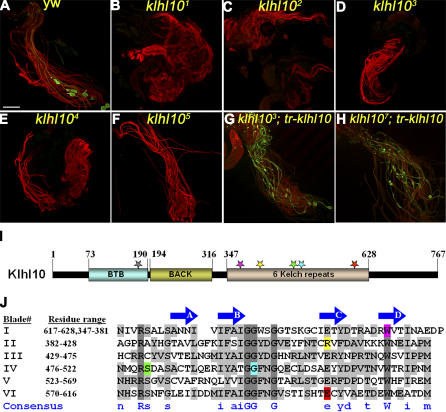
Mutations in klhl10 Block Caspase Activation and Spermatid Individualization, but Not Axonemal Tubulin Polyglycylation(A–H) Visualization of active effector caspase with anti-cleaved caspase-3 antibody (CM1; green) and (A–F) axonemal tubulin polyglycylation with anti-glycylated tubulin monoclonal antibody (AXO 49; red) or (G–H) F-actin, which stains the ICs and the spermatids' tails (phalloidin; red). These figures are composed of combined green and red layers.(A) Wild-type individualizing spermatids positively stain for cleaved caspase-3 and polyglycylated axonemal tubulin.(B–F) In a variety of klhl10
−/− alleles, elongated spermatids stain for polyglycylation but not for cleaved caspase-3.(G and H) Transgenic klhl10 construct (tr-klhl10, composed of cul3Testis promoter and 5′ UTR, klhl10 coding region, and cul3Testis 3′ UTR) restores caspase activation, spermatid individualization, and fertility to klhl10
−/− male flies.(I) Schematic representation of the Klhl10 protein. The relative locations of the BTB, BACK, and Kelch domains are depicted by thick bars. Different colored stars depict the locations of the different mutations, and the colors correspond to the colored amino-acids in (J). The molecular nature of the mutations and their color code are as follows: klhl102 (Z2–1331) carries a G1801-to-A transversion that converts glutamic acid (E601, red) to lysine at repeat VI. klhl103 (Z2–0960) carries a G1119-to-A transversion that converts tryptophan (W373, purple) to stop codon, resulting in a deletion of most of the Kelch domain. klhl104 (Z2–2739) carries a C1237-to-T transversion that converts arginine (R413, yellow) to stop codon, which also deletes most of the Kelch repeats. klhl105 (Z2–3284) carries a G1486-to-A transversion that converts glycine (G496, blue) to arginine at repeat IV. klhl106 (Z2–4385) carries a C1439-to-T transversion that converts serine (S480, green) to phenylalanine at repeat IV. On the other hand, klhl107 (Z2–3353) carries a G508-to-A transversion that converts a highly conserved alanine (A170) to threonine in the BTB domain (gray star).(J) Alignment of the six Kelch repeats of Klhl10. The alignment is based on the crystal structure of the Keap1 Kelch domain which folds into a β-propeller structure with 6 blades. The residue range for each blade is indicated at the left. The four conserved β-strands in each blade are indicated above the sequences by arrows. Residues conserved in all six blades are highlighted with dark gray and appear in upper case in the consensus line, whereas residues that are conserved in at least three blades appear in lower case. Any two and above conserved residues are highlighted with light gray. Color highlighted residues are mutated in the various klhl10−/− alleles and correspond to the stars in (I).